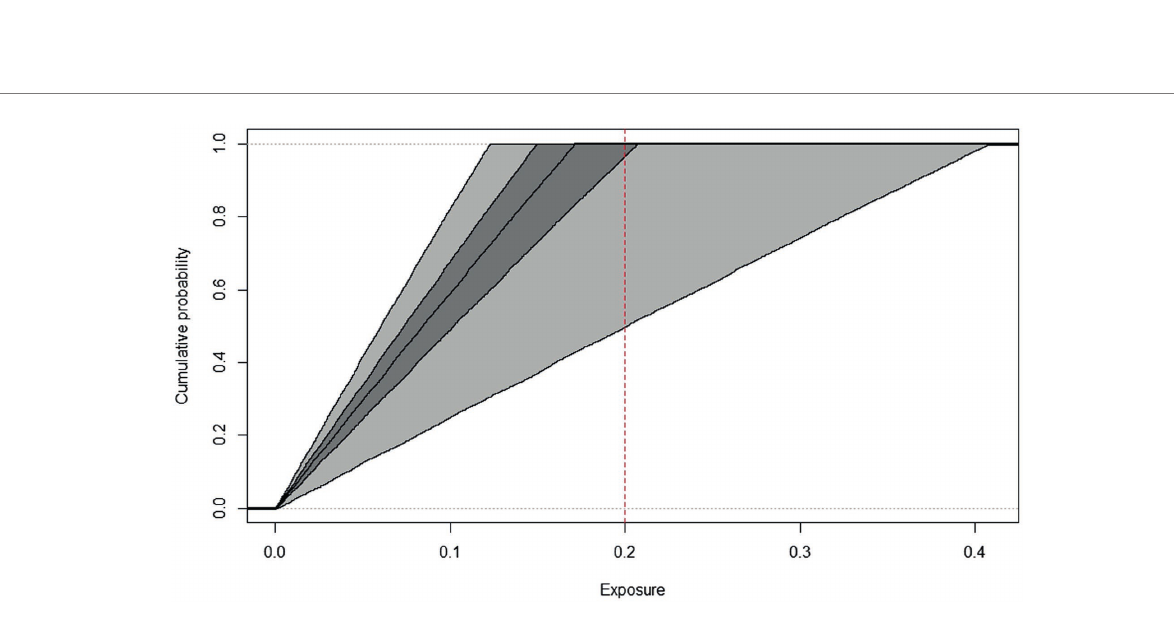
FIGURE 6 Cumulative frequency distributions of AFM1 exposure of children, indicating the threshold used for HI calculation (dashed line), years 2011–2022.